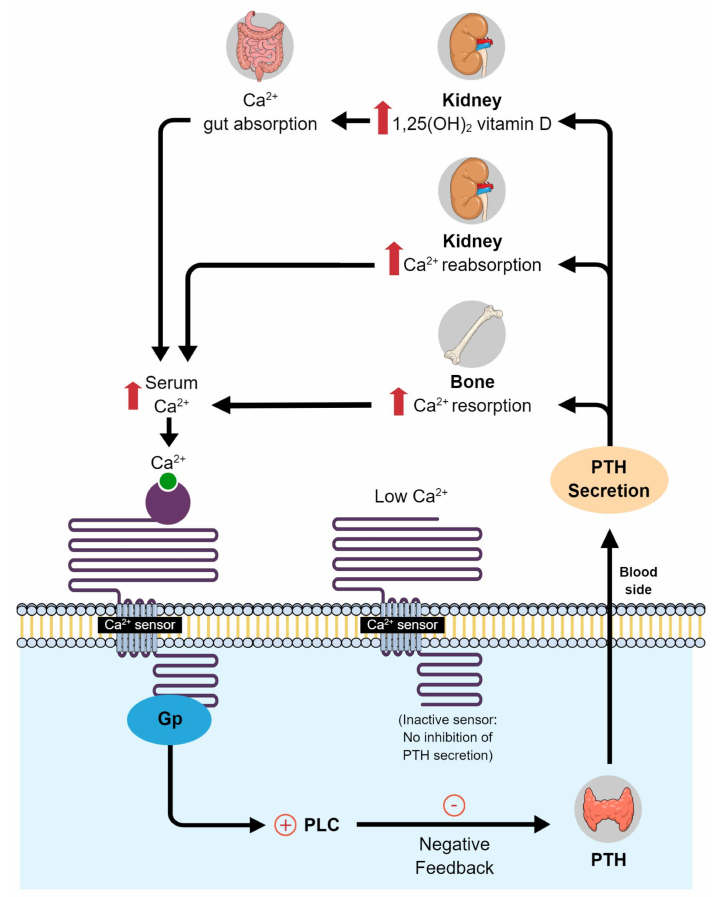
Figure 1. Calcium and vitamin D metabolism in the body. PLC, phospholipase C; PTH, parathyroid